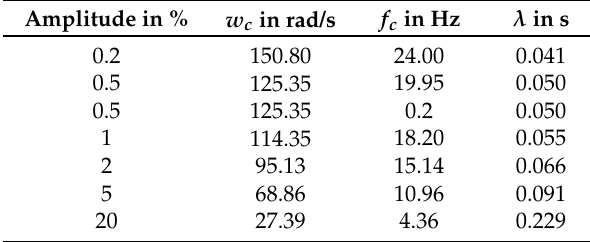
Table 3. Relaxation times λ for strain amplitudes γ 0 .